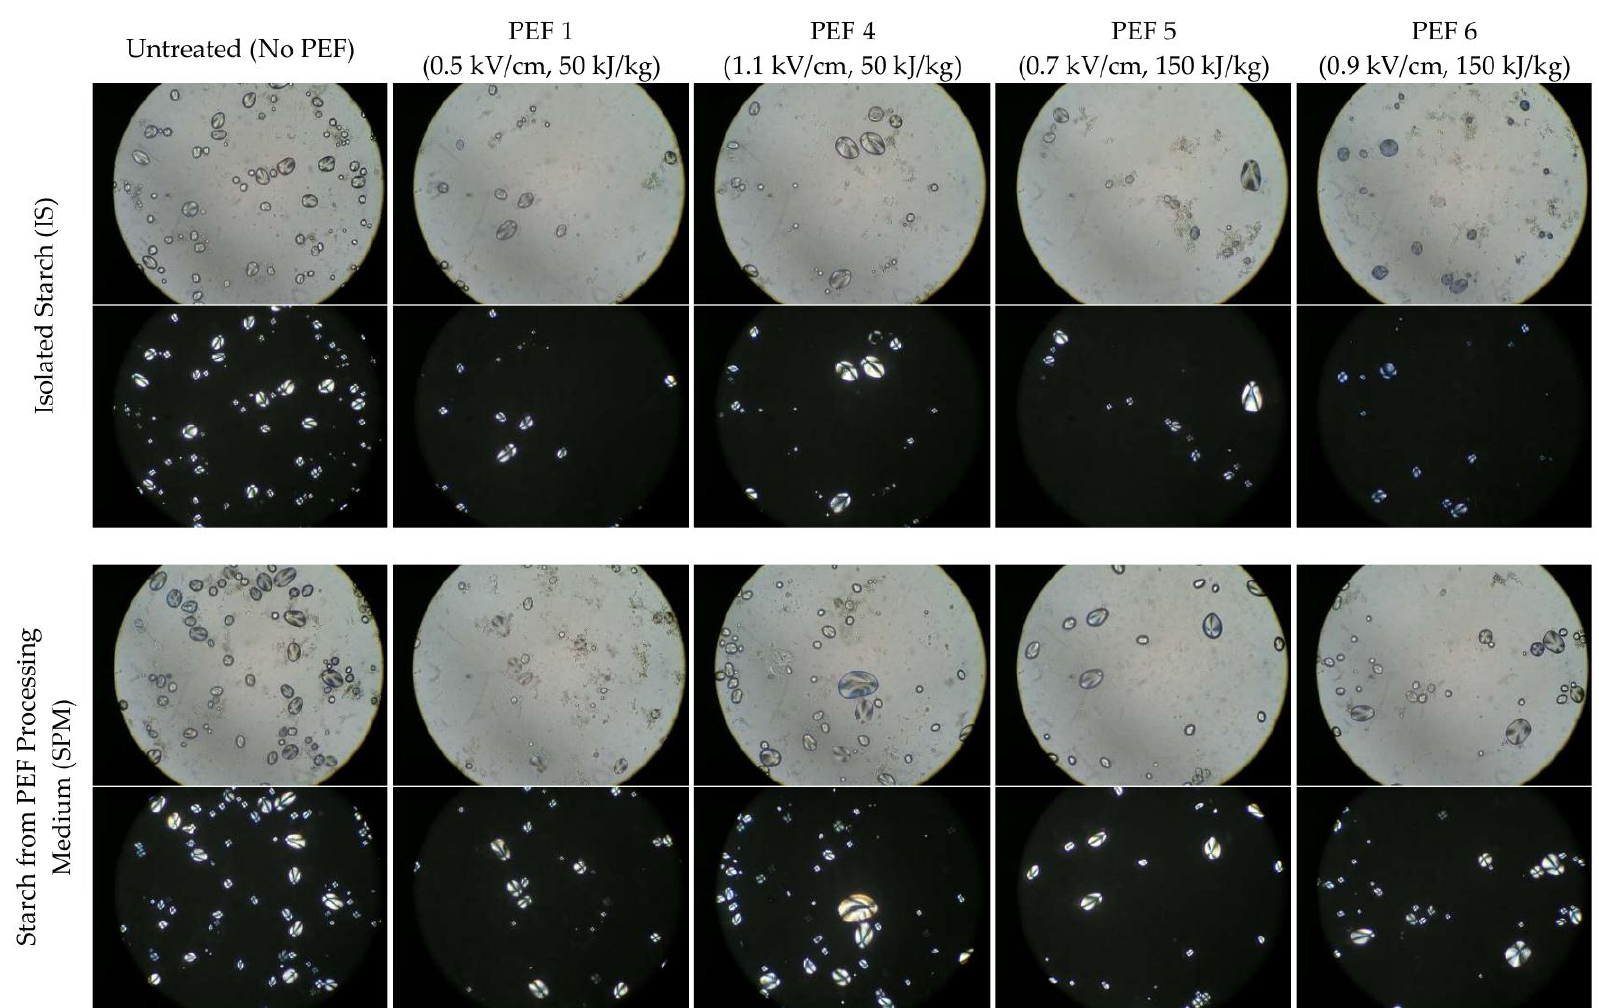
Figure 2. Selected light ( top ) and polarised ( bottom ) micrographs at a magnification of 400 × of isolated starch (IS) and starch from PEF processing medium (SPM) of untreated and PEF-treated potatoes.